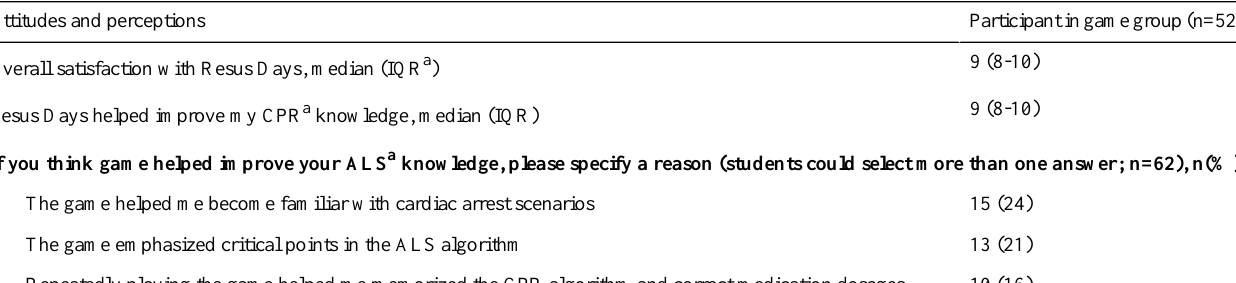
Table 3. Participant attitudes and perceptions regarding Resus Days based on a score of 1=strongly disagree to 10=strongly agree.